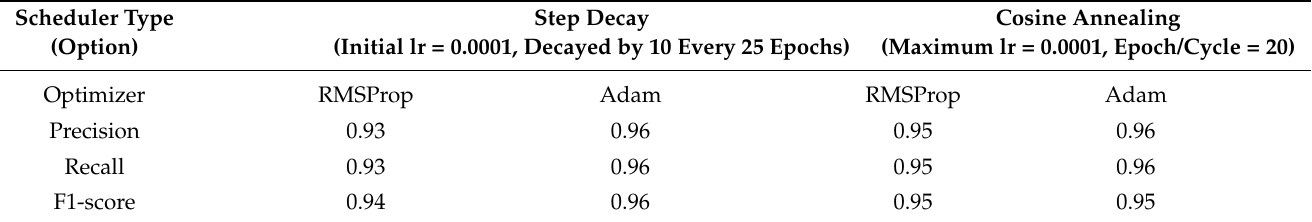
Table 1. F1-score results with different optimizers and learning rate